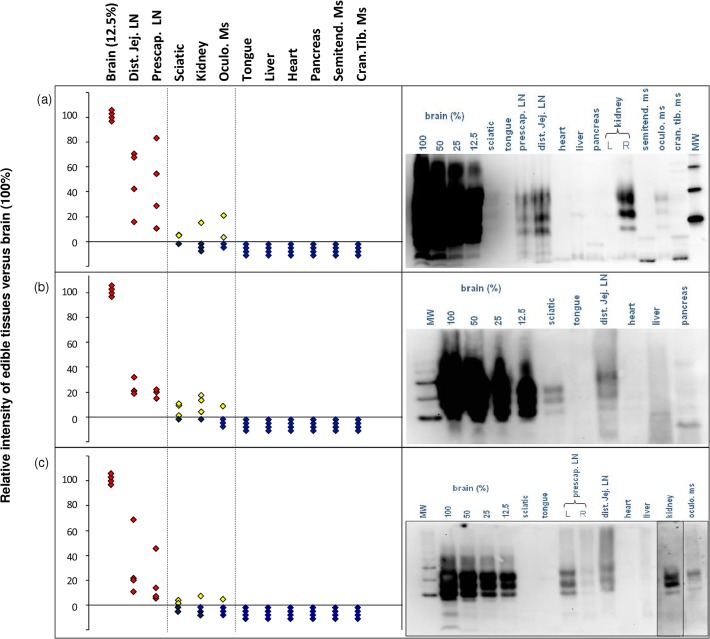
Relative intensity of chemiluminescent signal of PrPSc in tissues from 4 ARQ/ARQ sheep measured from Western blot image data (see adjacent panel) of edible tissues compared with a 12.5% dilution of brain sample by three western blot methods.(a) BioRad TeSeE Western Blot, (b) centrifugal concentration, (c) NaPTA precipitation. Red diamonds indicate high signal; yellow – low signal; blue – negative.